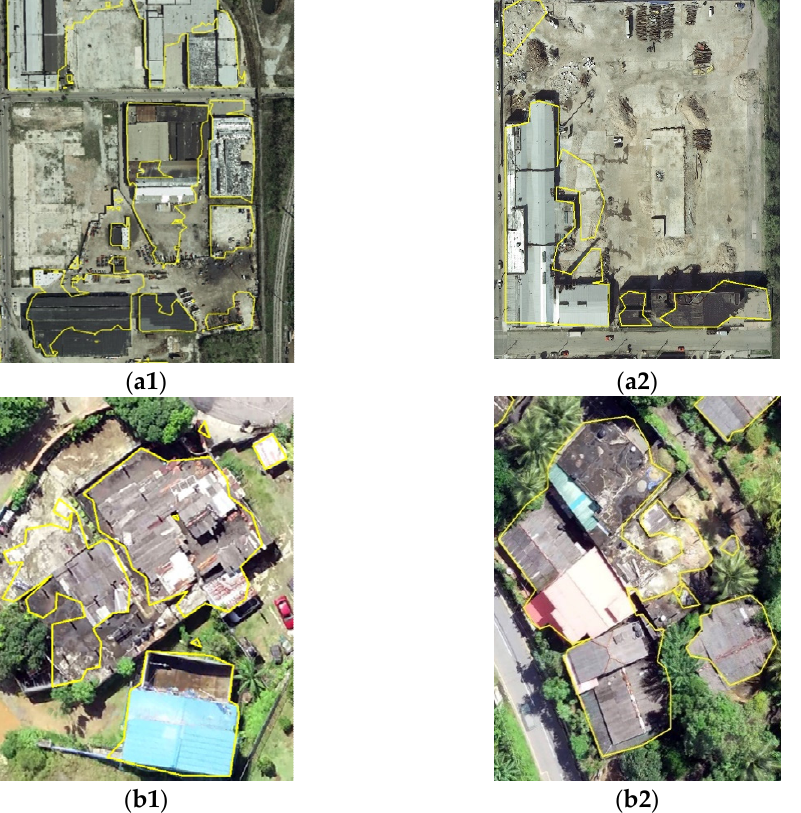
Figure 18. Detected buildings with imperfect boundaries in aerial and UAV images: ( a1 ) and ( a2 ) show imperfect building boundaries in aerial images; ( u1 ) and ( u2 ) show imperfect building boundaries in UAV images.